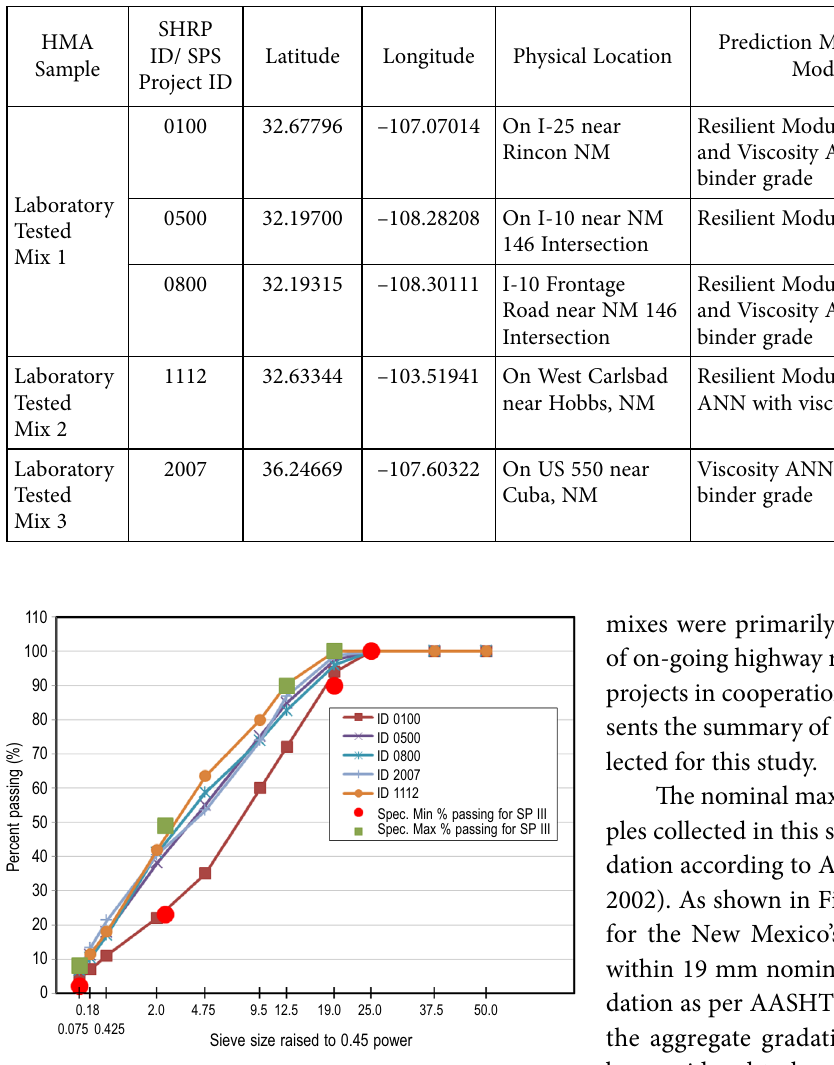
Fig. 1. Gradation curves for the HMA materials at LTPP